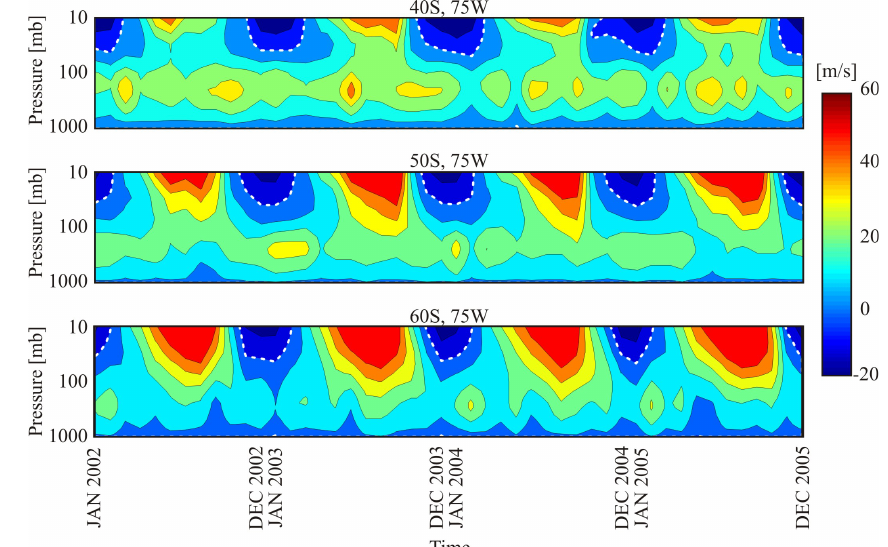
Fig. 3. NCEP reanalysis zonal wind. White dashed lines represent zero